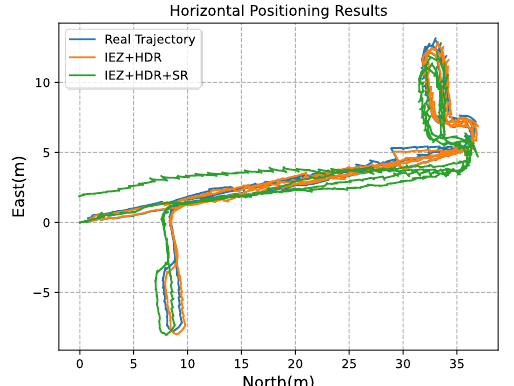
Figure 7 . Horizontal positioning results (Experiment 1).